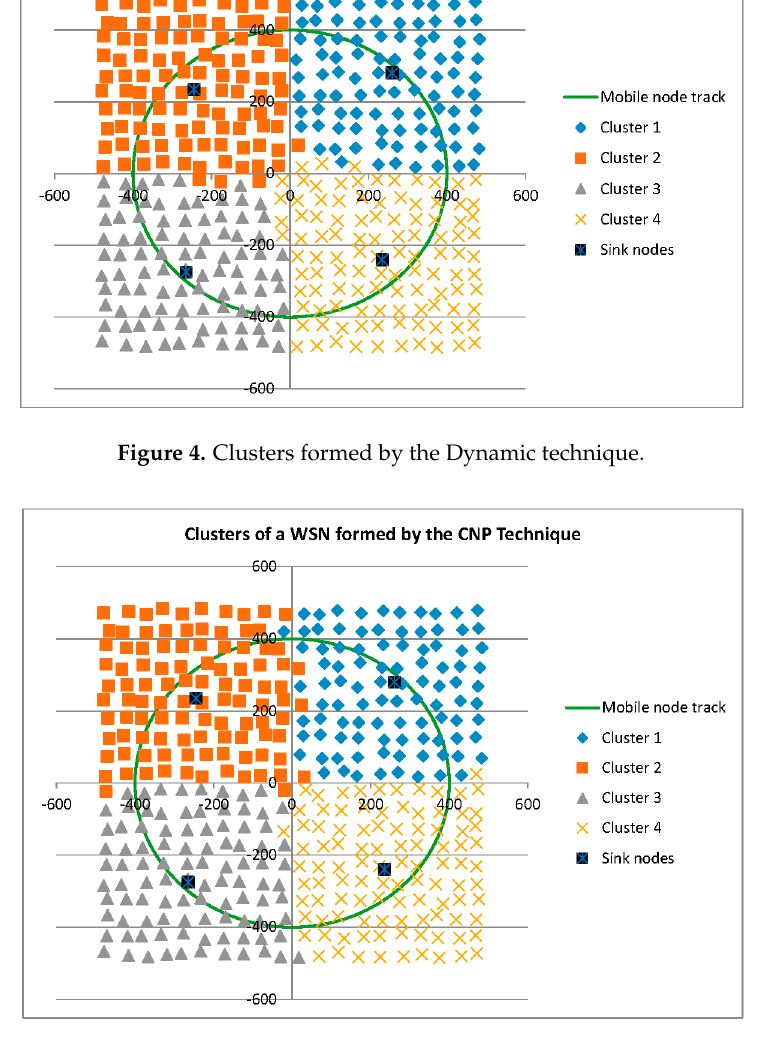
Figure 5. Clusters formed by the Static technique.